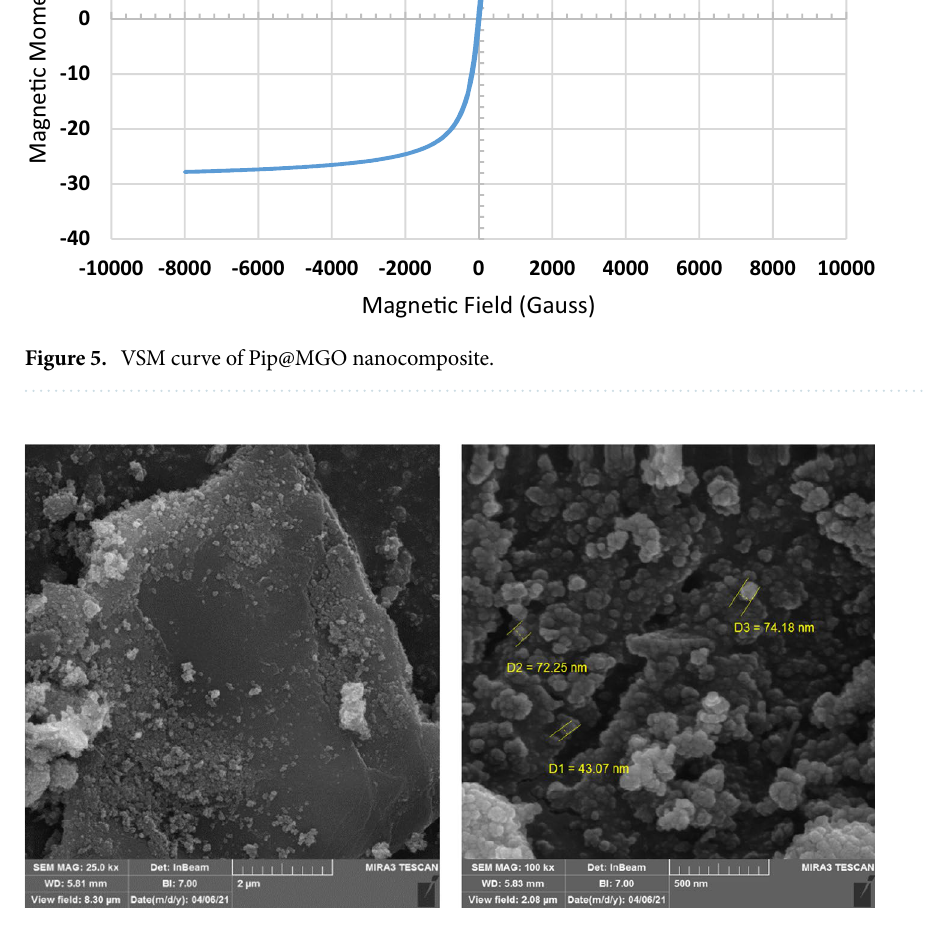
Figure 6. SEM images of Pip@MGO